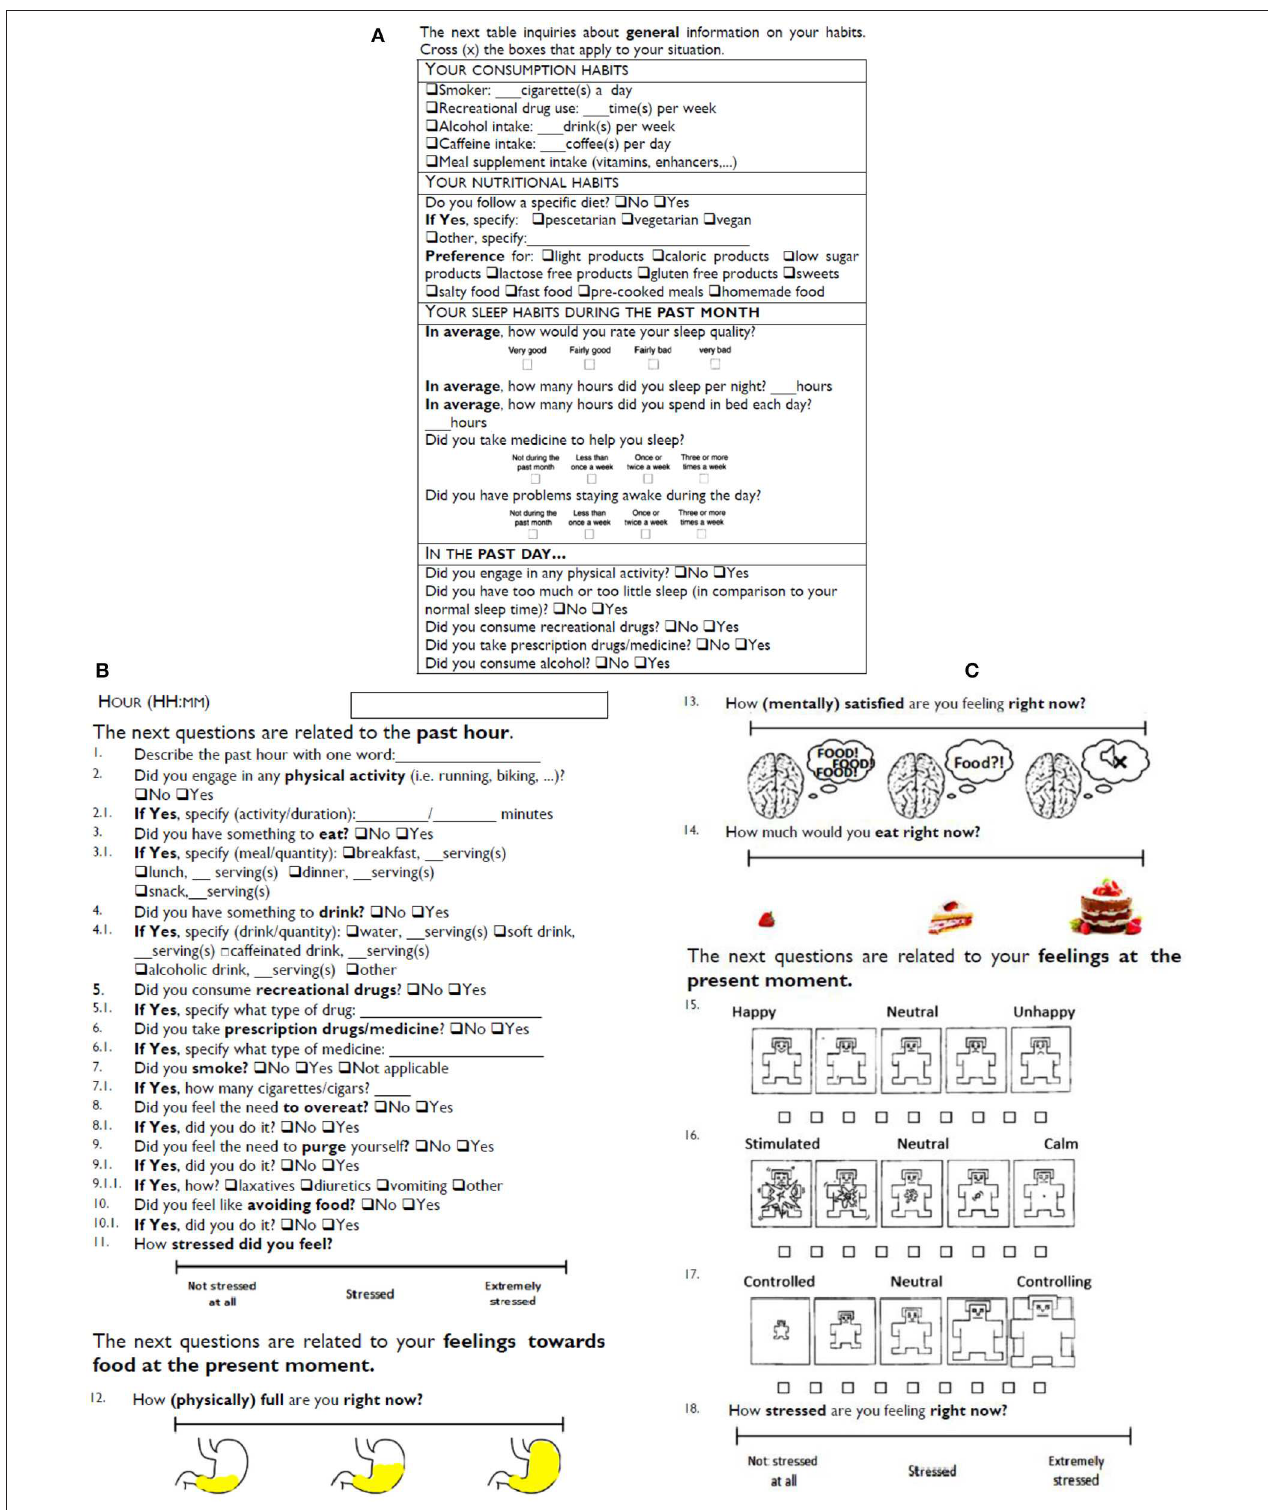
FIGURE 3 | Diary: (A) Background, (B,C) Hourly report.